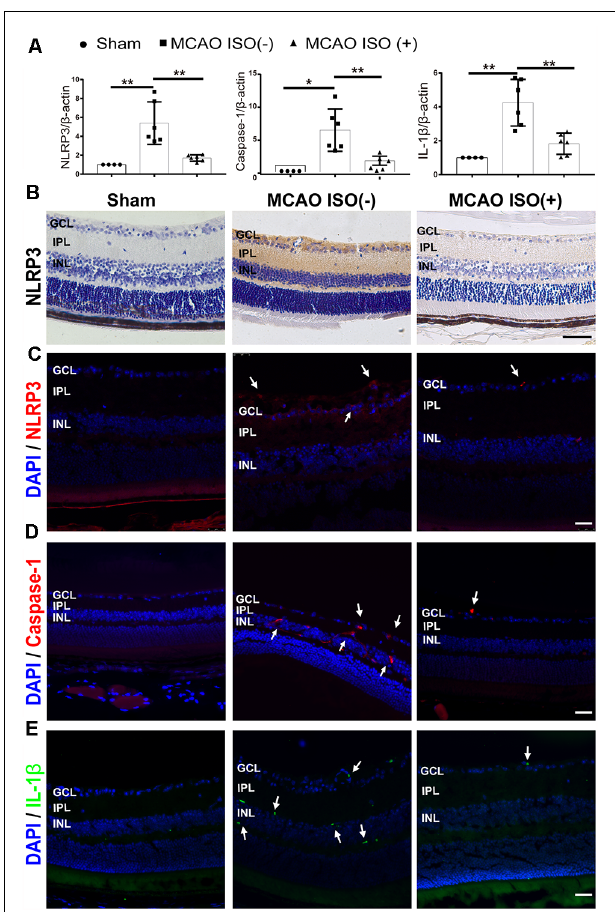
FIGURE 4 | ISO inhibits NLRP3 inflammasome activation in the retina after ischemic stroke in diabetic mice. (A) Relative gene expression of NLRP3, caspase-1, and IL-1 β in the retina. β -Actin served as an endogenous reference gene ( n = 4 in Sham group; n = 6 in MCAO ISO ( − ) group and MCAO ISO (+) group). (B) Representative immunohistochemical staining for the protein expression of NLRP3 in the retina (magnification, 400 × ; scale bar, 50 µ m). (C–E) Representative immunofluorescence staining for the protein expression of NLRP3 (C) , Caspase-1 (D) , and IL-1 β (E) in the retina. Arrow, NLRP3 (Red), Caspase-1 (Red), and IL-1 β (Green) positive cells (magnification, 400 × ; scale bar, 25 µ m). GCL, ganglion cell layer; IPL, inner plexiform layer; INL, inner nuclear layer. * P < 0.05, ** P <